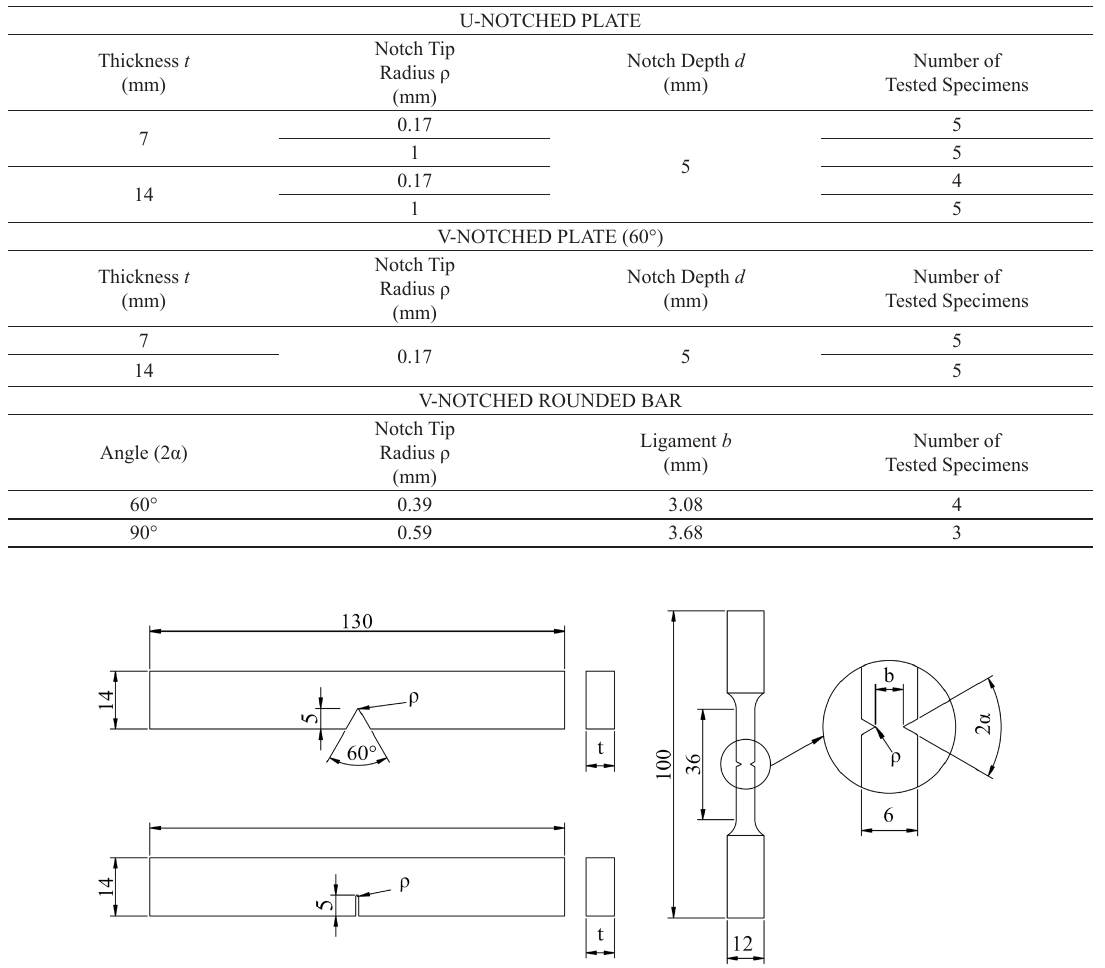
the specimens were oil quenched and then tempered at 390°C for 30 min, followed by furnace cooling. Austenitization was performed in a neutral salt bath to prevent decarburization 16 . Heating rates were established at 0.35°C/min.